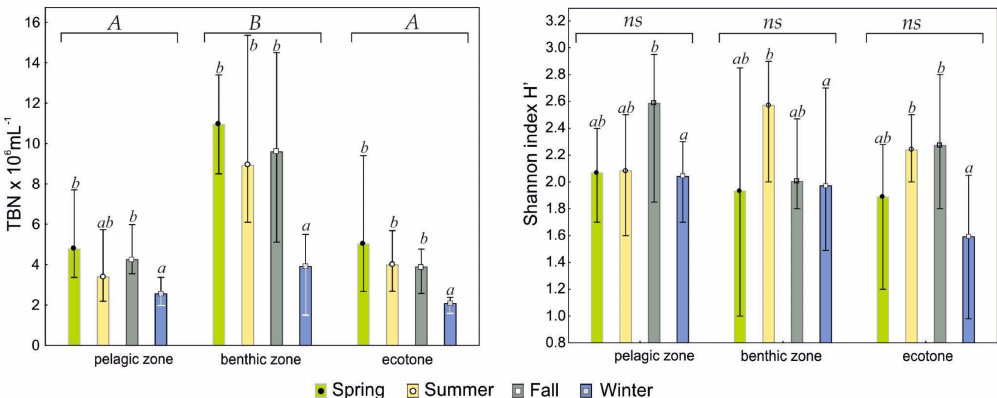
Figure 3. Seasonal differences in abundances of bacteria (TBN) ( left graph ) and bacteria diversity expressed Shannon index (H’) ( right graph ) in the studied parts of the peat bog lakes. The heights of bars denote means for lakes and the error bars represent standard deviations. Means that do not share superscripts differ by p < 0.05 according to the Tukey’s test (post hoc, two-way ANOVA). The homogeneous subsets output, expressed by combination of ab superscripts, shows groups of means that do not differ significantly from each other. Statistical differences between groups of means for sites been indicated with capital letters A and B above the bars; ns —no statistical significance among H’ in